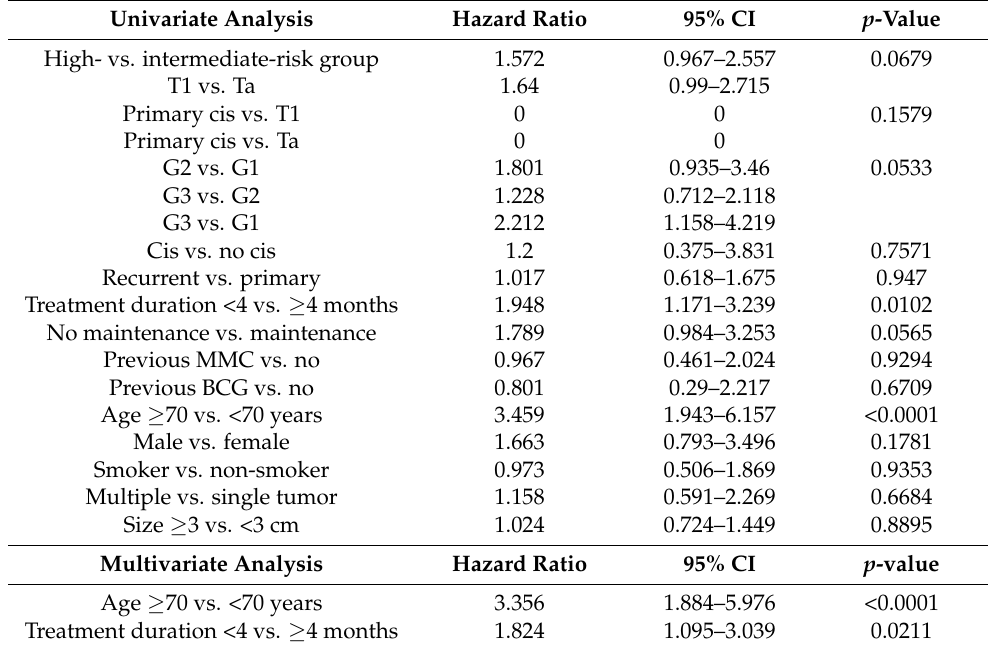
Table 5. Cox regression model to predict tumor overall survival, FAS population ( n = 502).